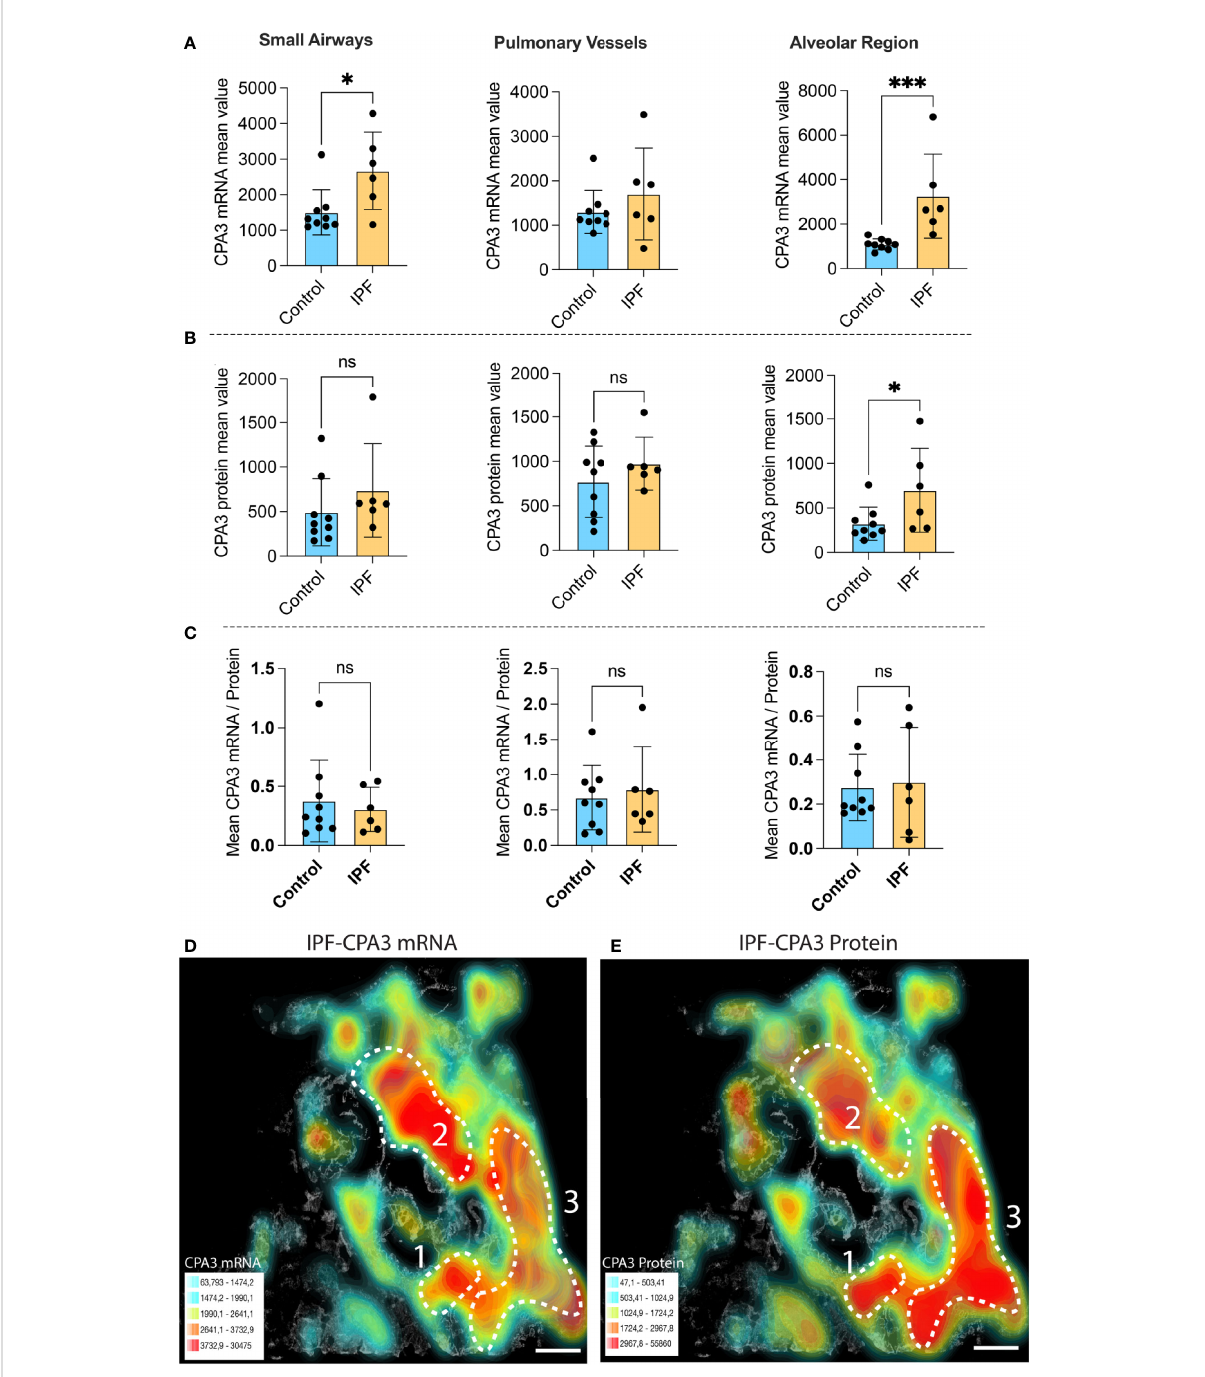
FIGURE 3 The expanded mast cell population in distal IPF lungs has a robust upregulation of both CPA3 mRNA and protein. (A – C) Mean patient values for individual mast cell expression of CPA3 mRNA (A) , CPA3 protein (B) , and the mean mRNA/protein quotient (C) across control subjects and COPD patients. A total of >81,000 individual mast cells were analyzed in the IPF disease group, and each dot denotes mean patient values of >12,000 mast cells per IPF patient. Statistical signi fi cance levels are indicated as ns = non-signi fi cant, * p < 0.05, and *** p < 0.001. (D, E) Low- power micrograph of a representative IPF lung section where a gray-scale background tissue is overlayed with color-coded density maps (high – low is shown as red – turquoise) displaying combined mast cell density and expression levels of CPA3 mRNA (D) or CPA3 protein (E) . Note that although both the level of protein and mRNA is high, the relative proportion varies across tissue microenvironments, as illustrated by a CPA3 mRNA high , protein moderate pro fi le in region 2 and a CPA3 mRNA moderate , protein high signature in region 3. Scale bars = 1.8